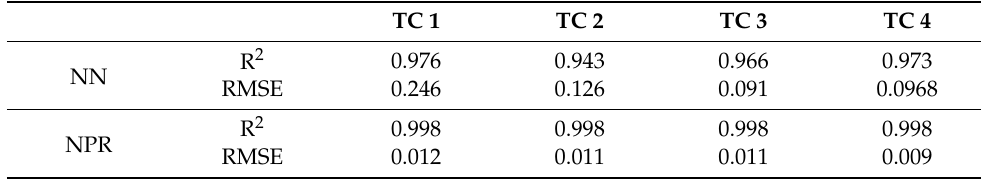
Figure 7. Goodness-of-Fit for the NN and NPR models. Table 5. Performance evaluation for each TC based on all DOE cases.